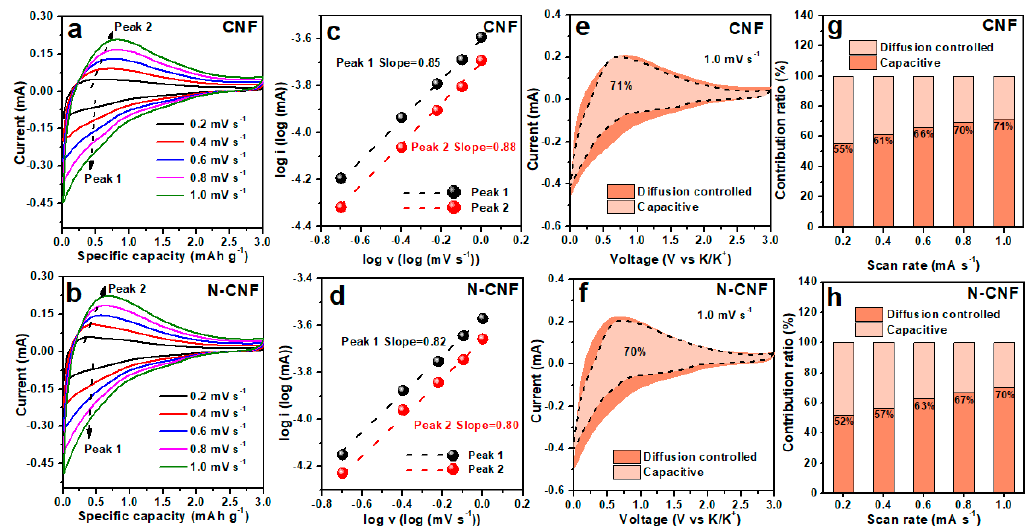
Figure 5. CV curves of ( a ) CNF and ( b ) N-CNF at different scan rates; relationship between log (i) and log (v) of ( c ) CNF and ( d ) N-CNF; capacitive contribution area of ( e ) CNF and ( f ) N-CNF at 1.0 mV s − 1 ; capacitive contribution ratios of ( g ) CNF and ( h ) N-CNF at different scan rates.